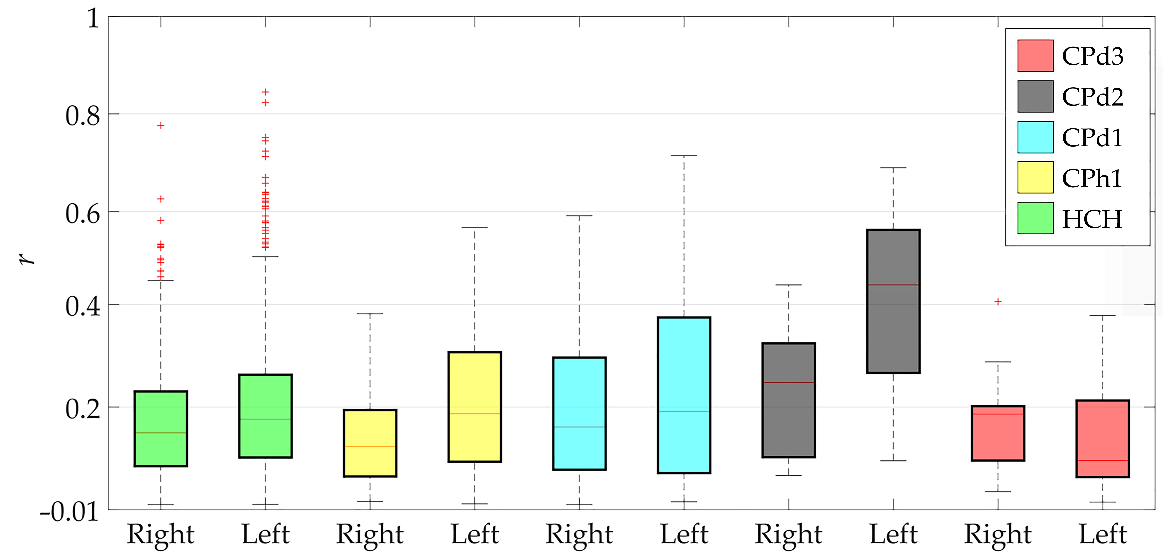
Figure 4. Mean values of the correlation coefficients. +, outliers of boxplots; HCH, healthy children.